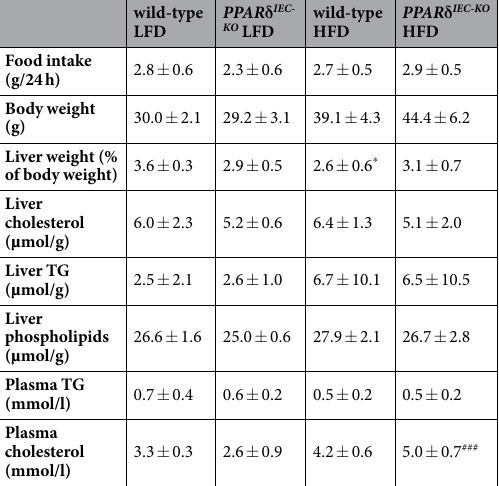
Table 2. Animal characteristics and liver composition of wild-type and PPAR δ IEC-KO mice after a LFD (n = 3–8) or HFD (n = 4–10). * Significantly different from wild-type on LFD (p < 0.05); ### Significantly different from PPAR δ IEC-KO on LFD (p < 0.001). Values are presented as means ±